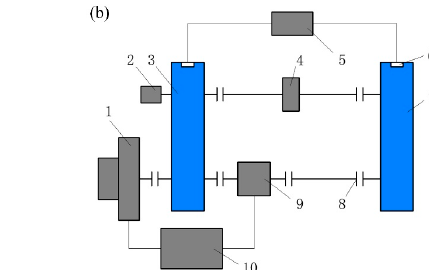
Table 1. Chemical composition (wt %) of 20CrH steel.